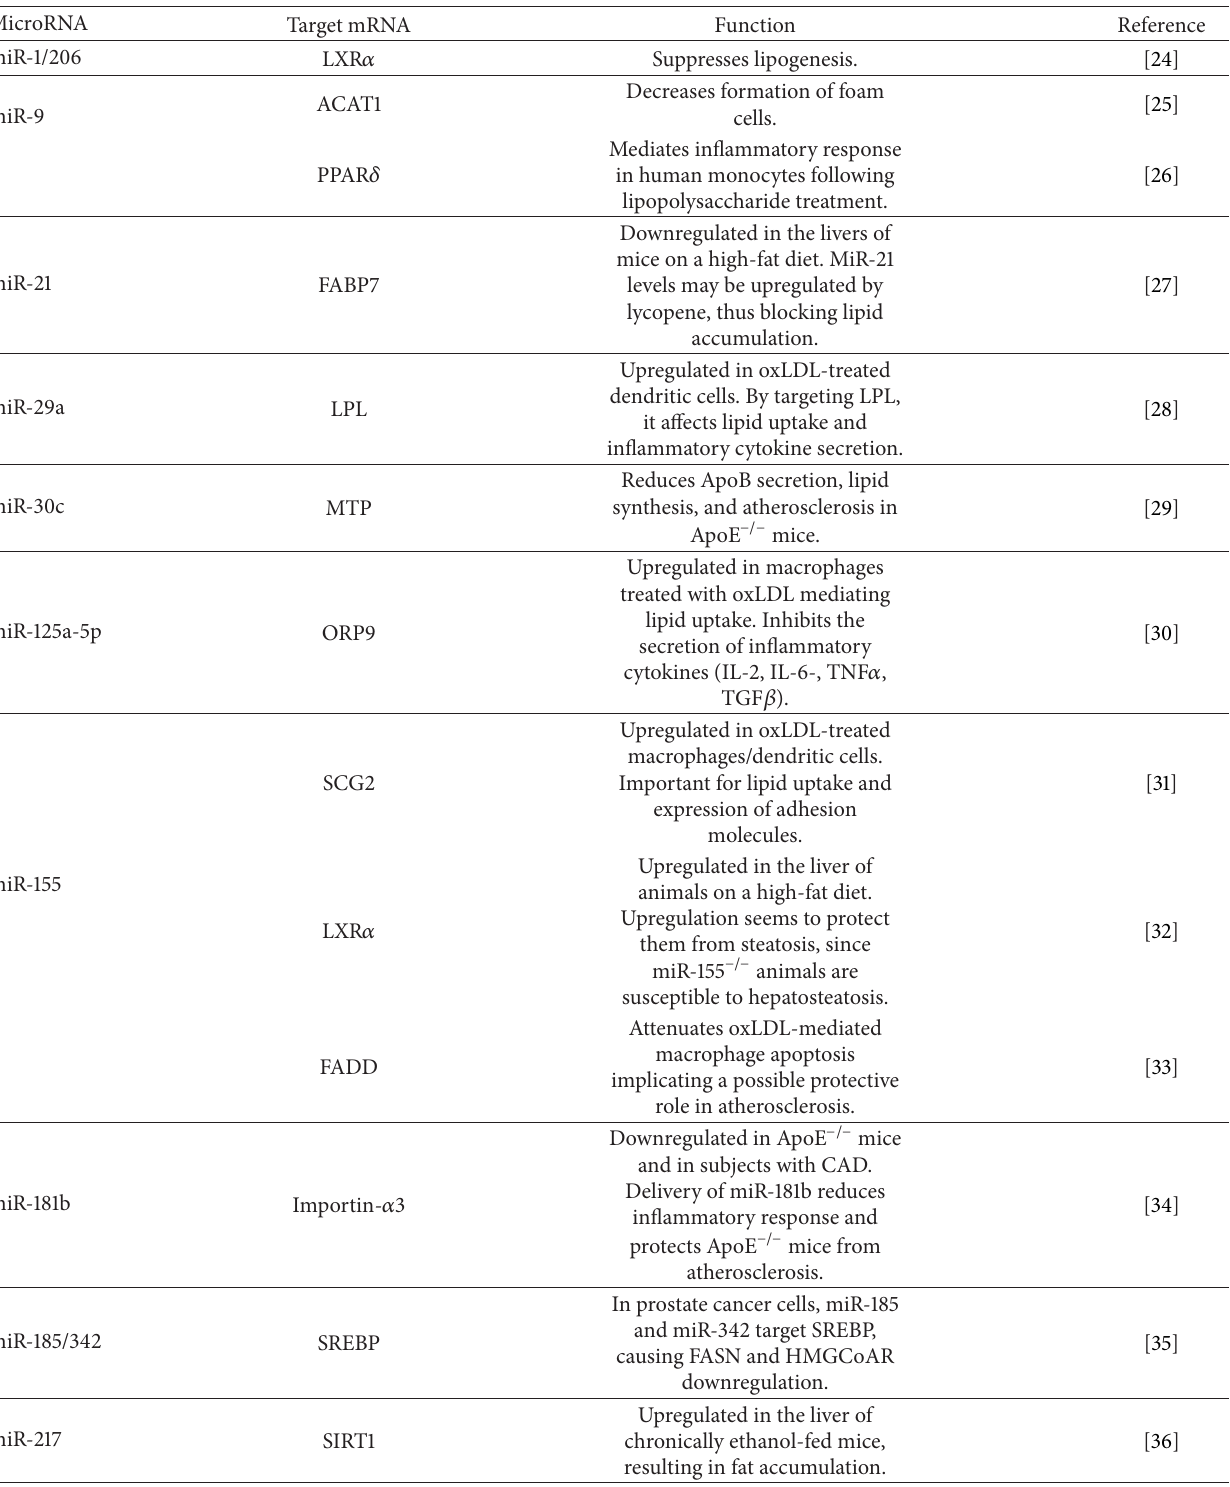
Table 2: Additional microRNAs involved in the lipid metabolism and